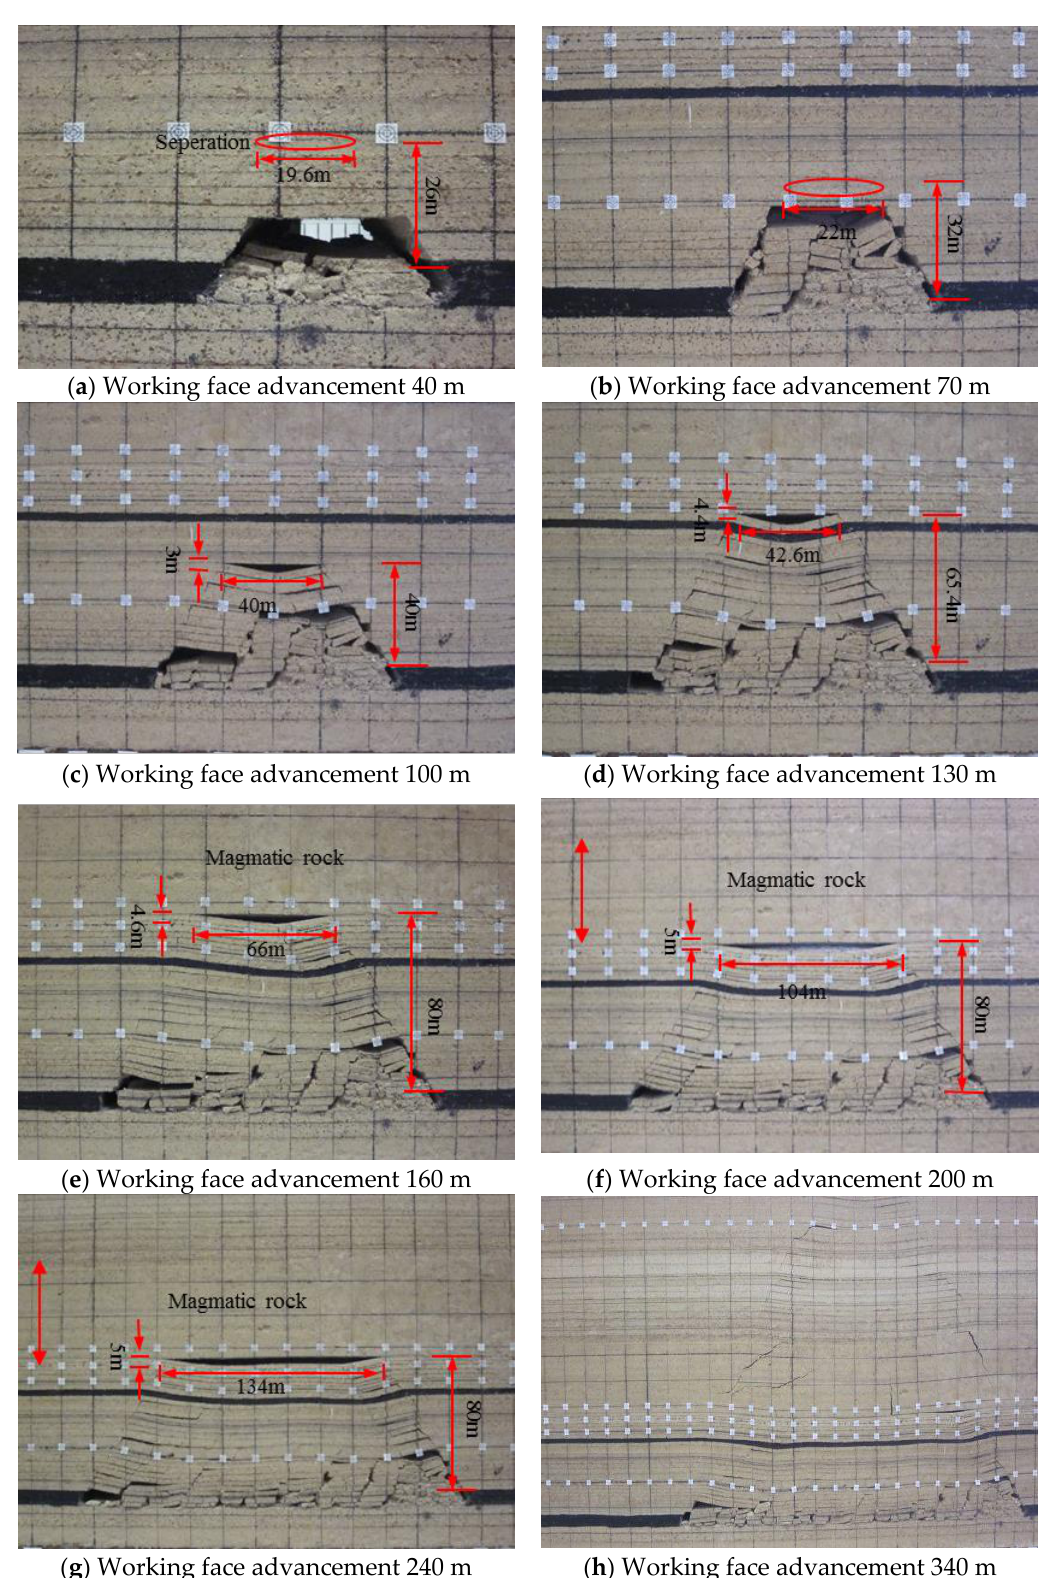
Figure 3. Evolution law of overburden bed separation.